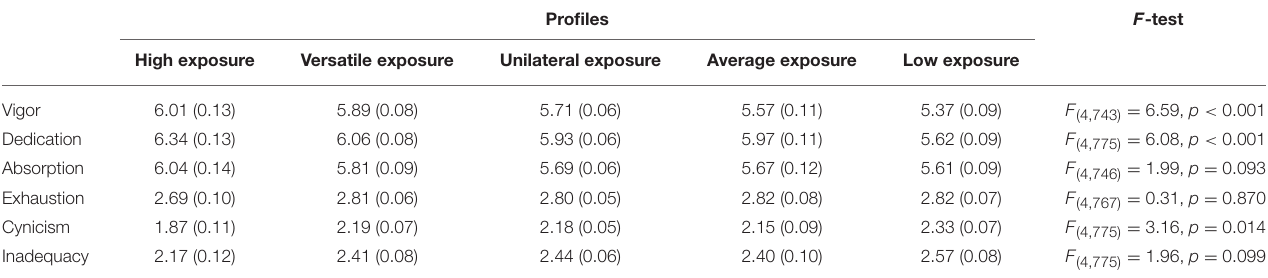
TABLE 6 | Estimated marginal means (and standard errors) of well-being outcomes for the profiles (see Table 7 for covariates used). Profiles F